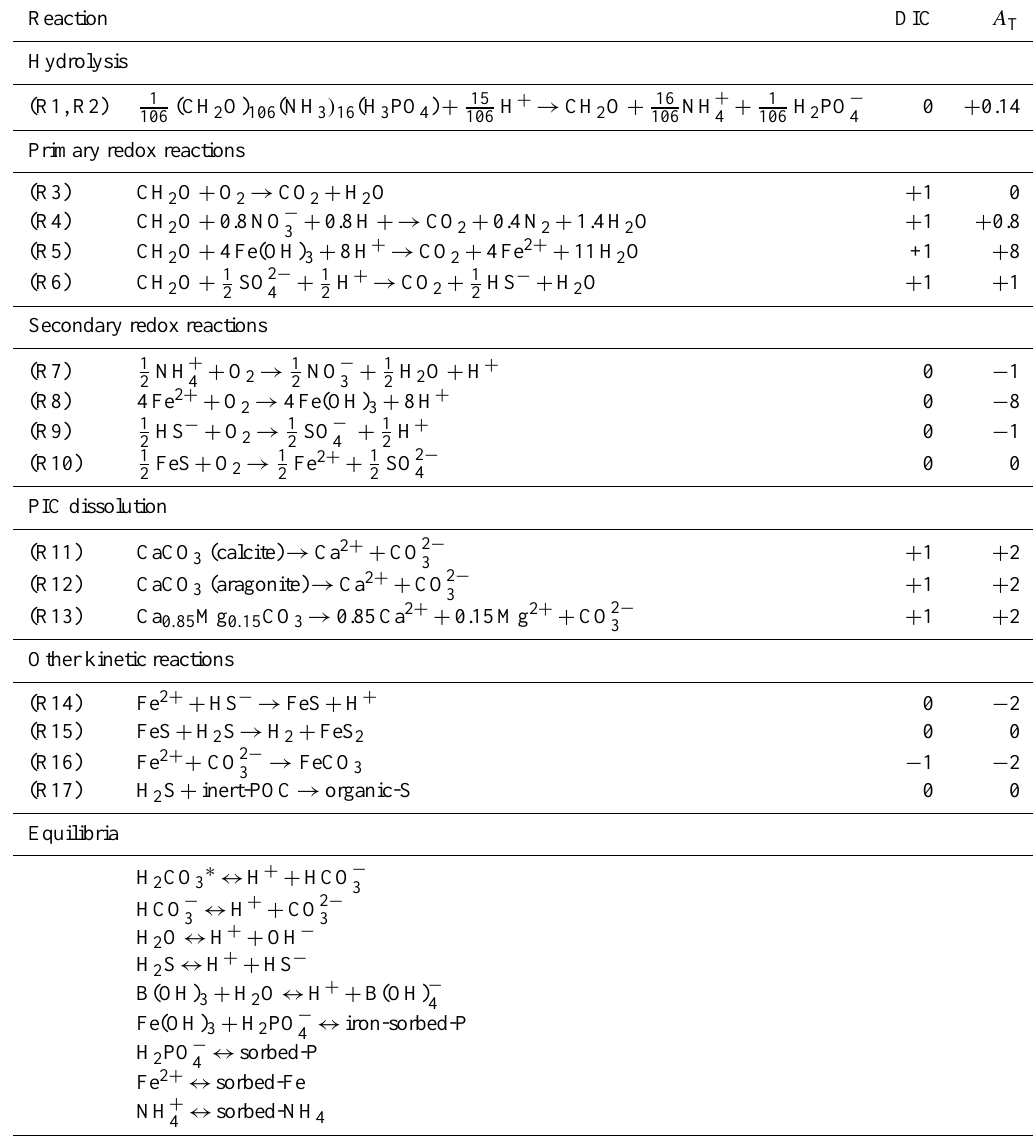
Table 3. Kinetic and equilibrium reactions, and generation of DIC and A T . Reaction DIC A T